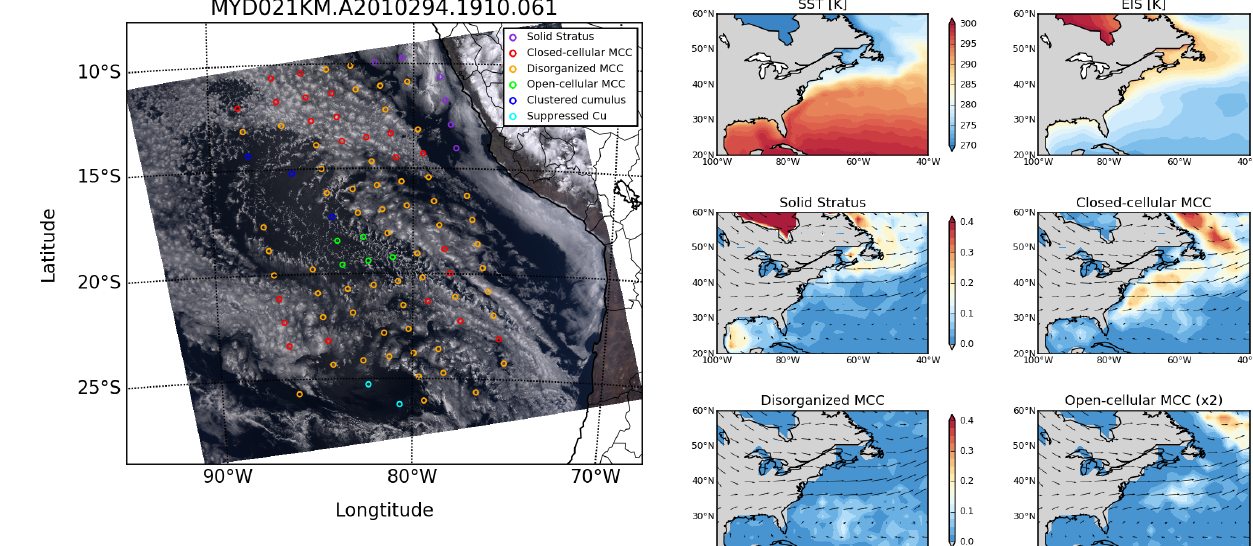
Figure 7. An example granule illustrating the results of the clas- sification algorithm. This is quite a complex granule with differ- ent morphology types mixed together. The left and right margins are not classified because the current algorithm filters out scenes whose sensor viewing zenith angles are greater than 45 ◦ . The im- age is taken by NASA MODIS.